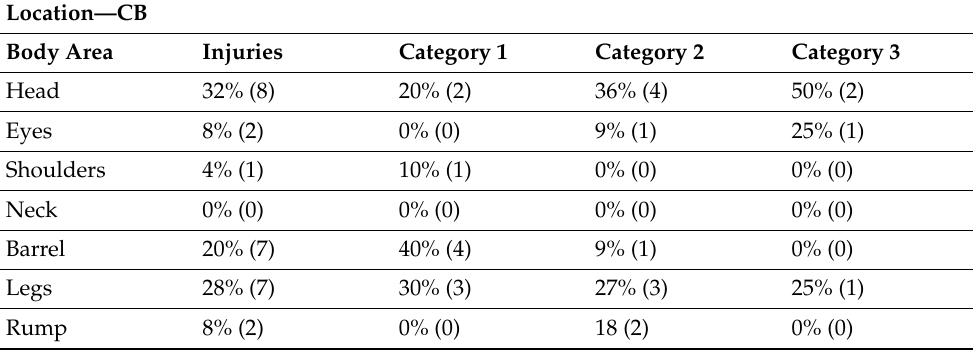
Table 8. Distribution of injuries in the conventional box (CB) stabling by severity and location on the horse’s body area in [%